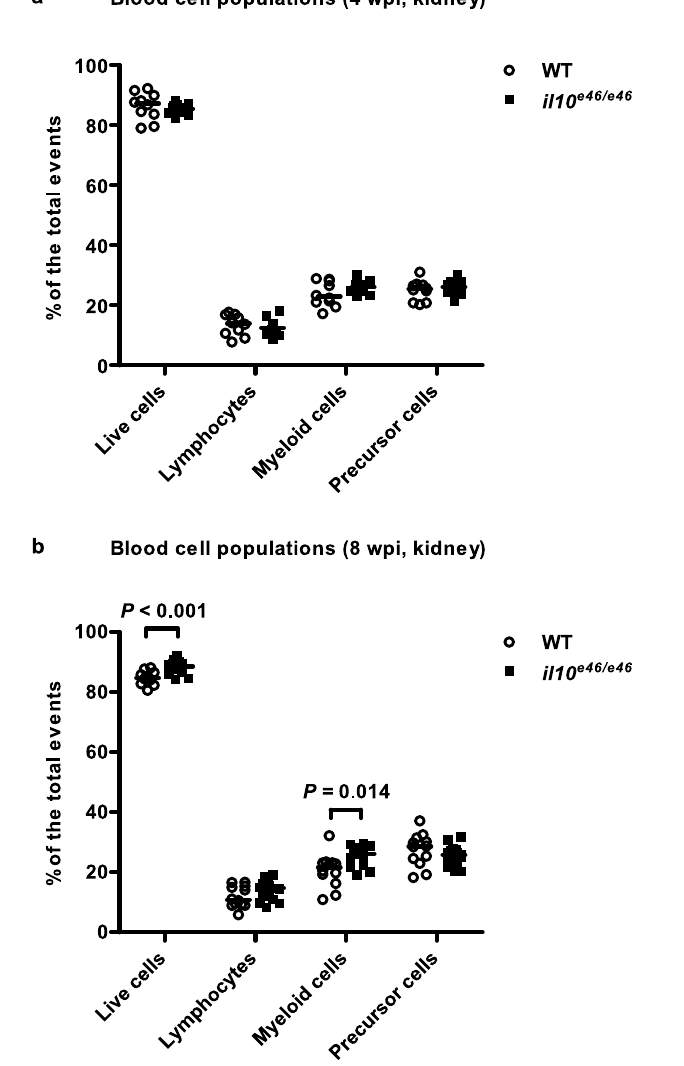
Figure 5. il10 e46/e46 mutation associates with a higher proportion of myeloid cells at 8 weeks post a low-dose (1–18 CFU) M. marinum infection. ( a , b ) The relative proportions of live cells, lymphocytes, precursor cells and myeloid cells were determined with flow cytometry from the kidneys of il10 e46/e46 mutants ( n = 10–15) and WT control fish ( n = 10–12) at 4 and 8 wpi based on granularity (SSC) and cell size (FSC). The data were collected from a single experiment and are presented as a scatter dot plot and median. A two-tailed Mann-Whitney test was used for the statistical comparison of differences between il10 e46/e46 zebrafish and WT